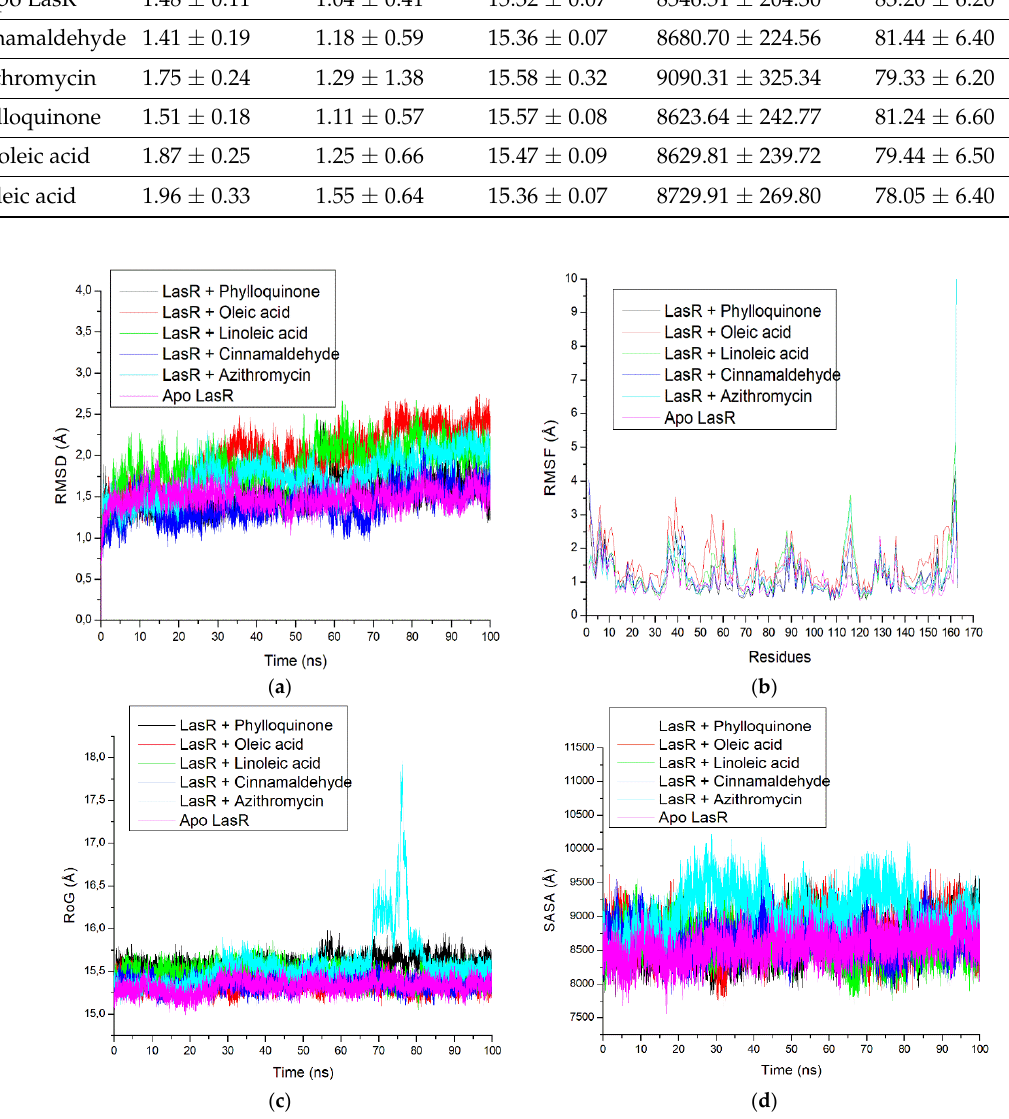
Table 8. Average RMSD, ROG, RMSF, SASA, and intramolecular hydrogen bond number of the top-three compounds against LasR of P. aeruginosa following a 100-ns simulation.